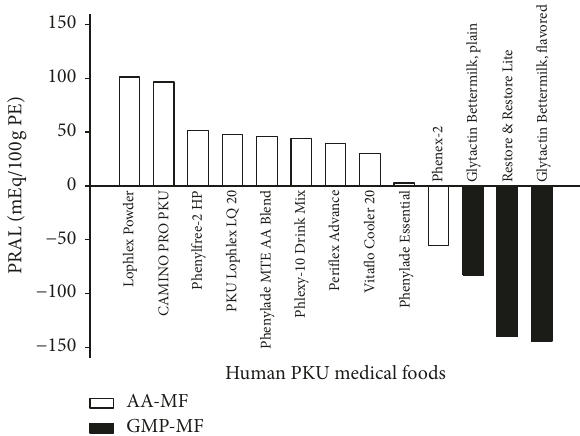
Figure 1: Potential renal acid load was calculated for 10 different AA-MF and 3 different GMP-MF, based on mineral and amino acid analysis, n = 2-3 per medical food. AA-MF, amino acid medical foods; GMP-MF, glycomacropeptide medical foods; PRAL, potential renal acid load; PE, protein